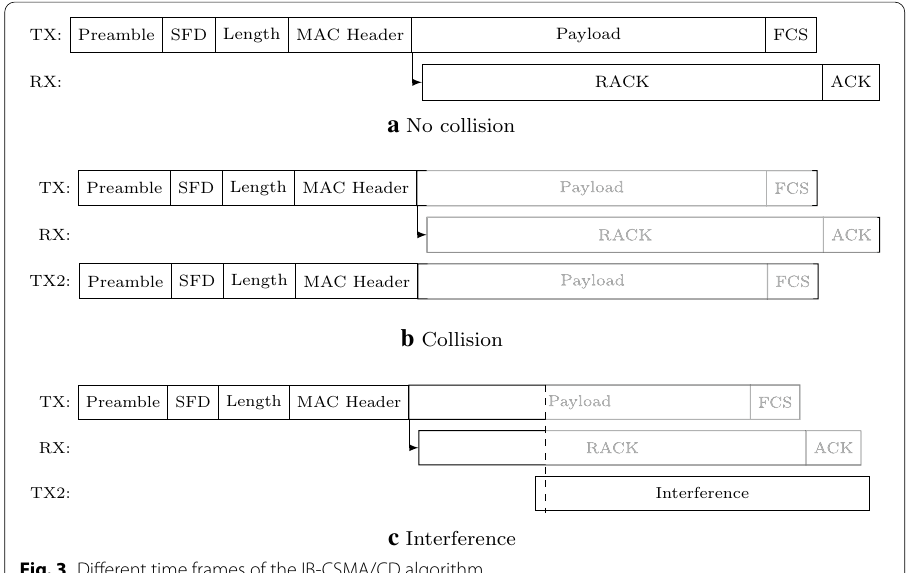
Fig. 3 Different time frames of the IB-CSMA/CD